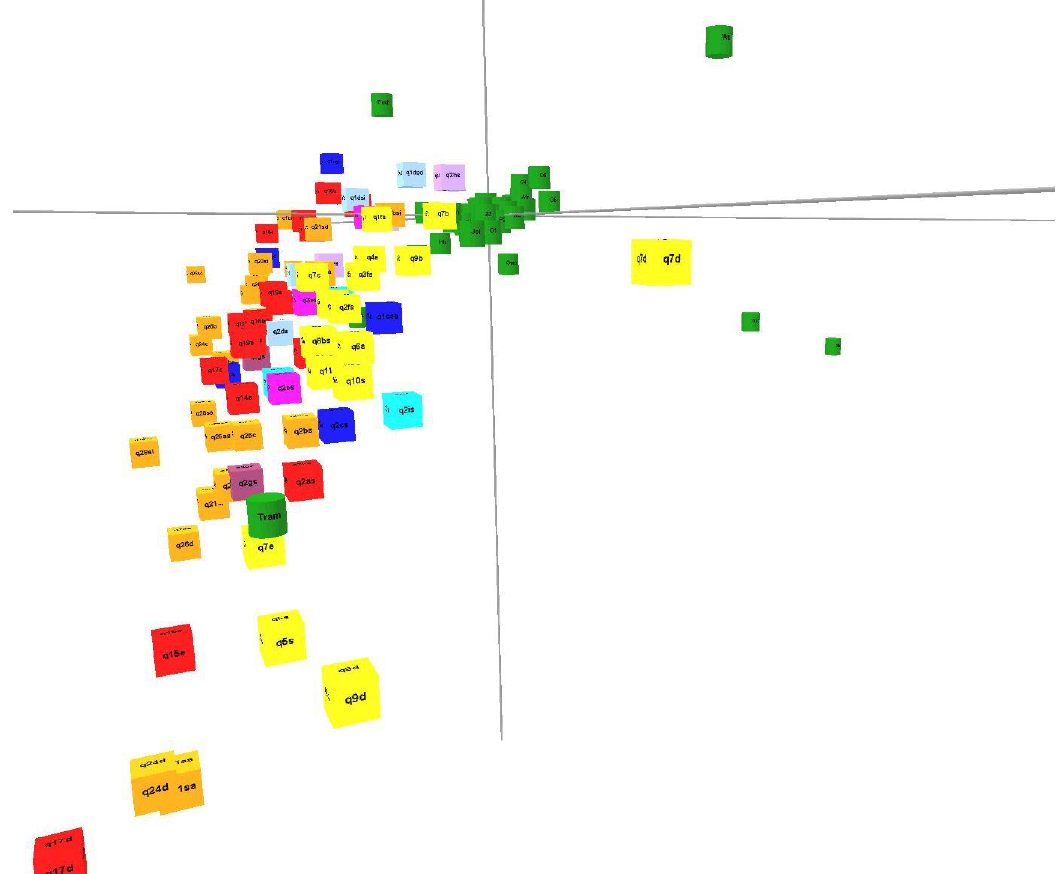
Figure 5. Relationship of all the categories differentiating ailments (shapes) and body areas (colors) without categories referring to the absence of ailments (Please see: https://youtu.be/AmHI6sHSzvE). Abbreviations: Please see Table 3 and Table A1—Appendix A.